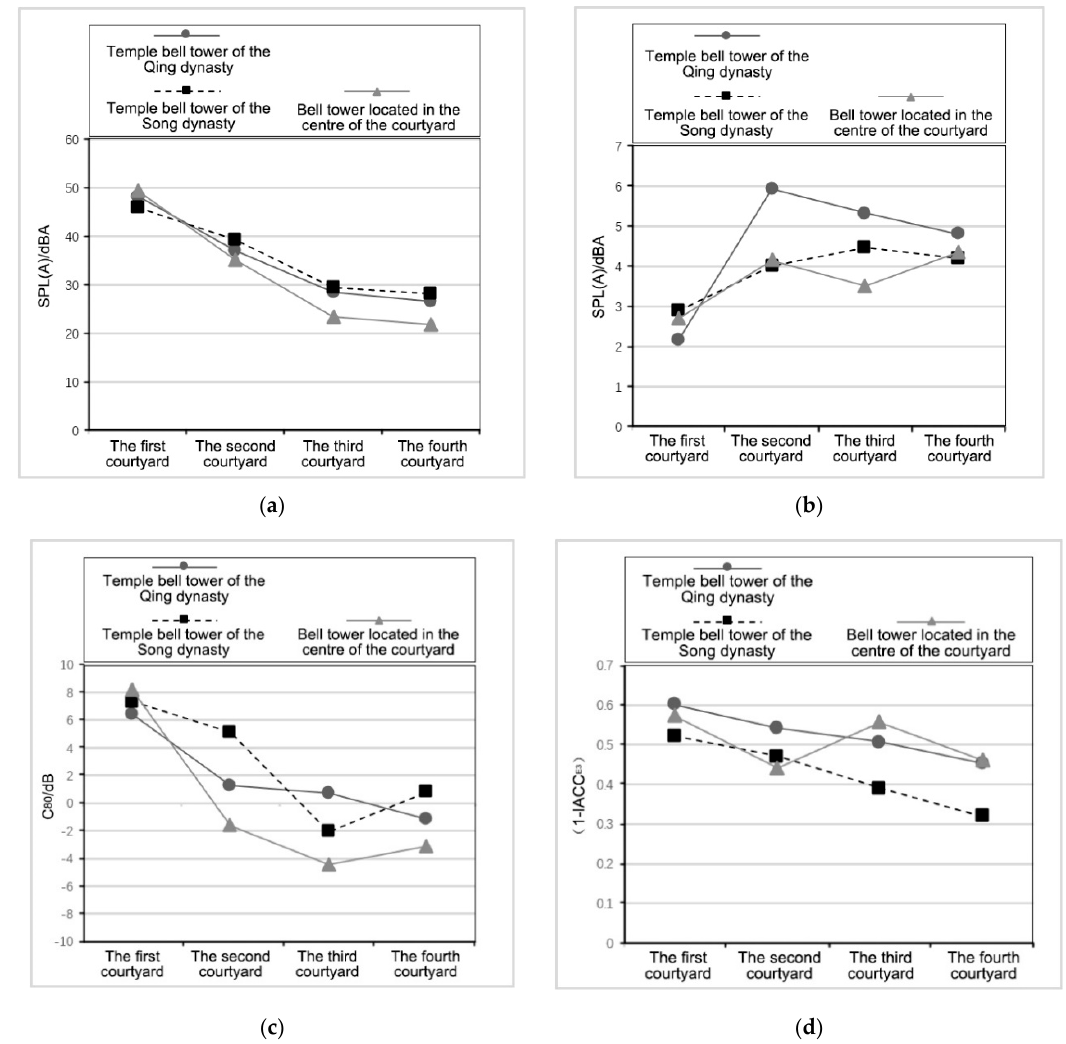
Figure 9. Diagrams of the effects of bell tower position on courtyard sound fields. ( a ) Variation in SPL(A). ( b ) Variation in the standard deviation of SPL(A). ( c ) Variation in C 80 . ( d ) Variation in (1 − IACC E3 ).